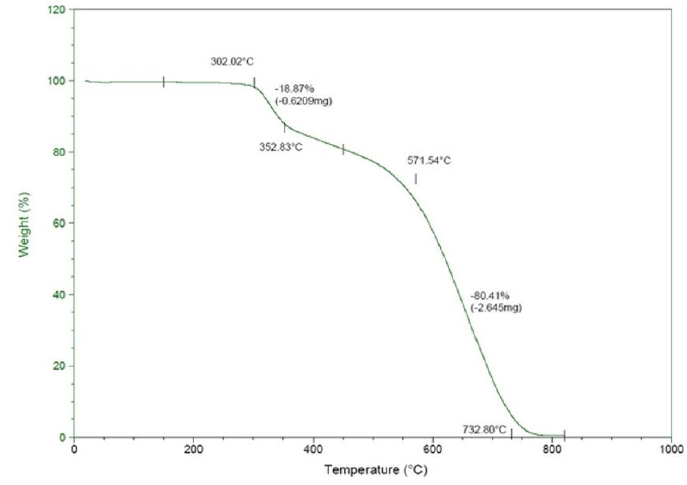
Figure 4. The Thermogravimetry analysis (TGA) curve of the PAN fibers prior to the carbonization.